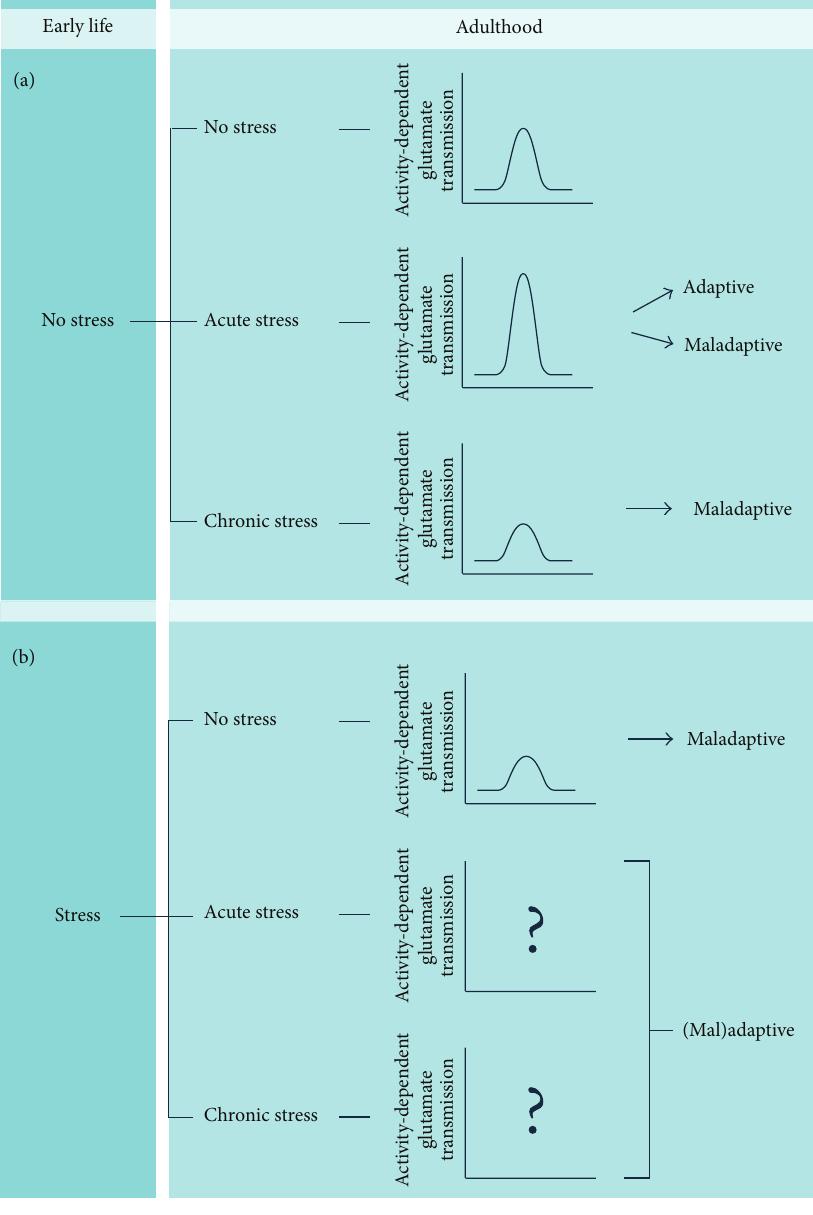
Figure 1: Influence of early-life stress on neuronal excitatory neurotransmission in corticolimbic areas. (a) In subjects with no history of perinatal adverse challenges, acute stress induces an increase in stimulation-evoked glutamate release. This response can be both adaptive and maladaptive. On the other hand, exposure to repeated episodes of stress (chronic stress) induces hypofunction of the glutamatergic synapse with reduced evoked glutamate release, associated with increased vulnerability to stress-related neuropsychiatric disorders. (b) Perinatal stress induces hypofunction of the glutamatergic synapse in adult life, with ensuing reduction in evoked glutamate release. The effects of the association between early- and late-life stress are largely unknown. See text for